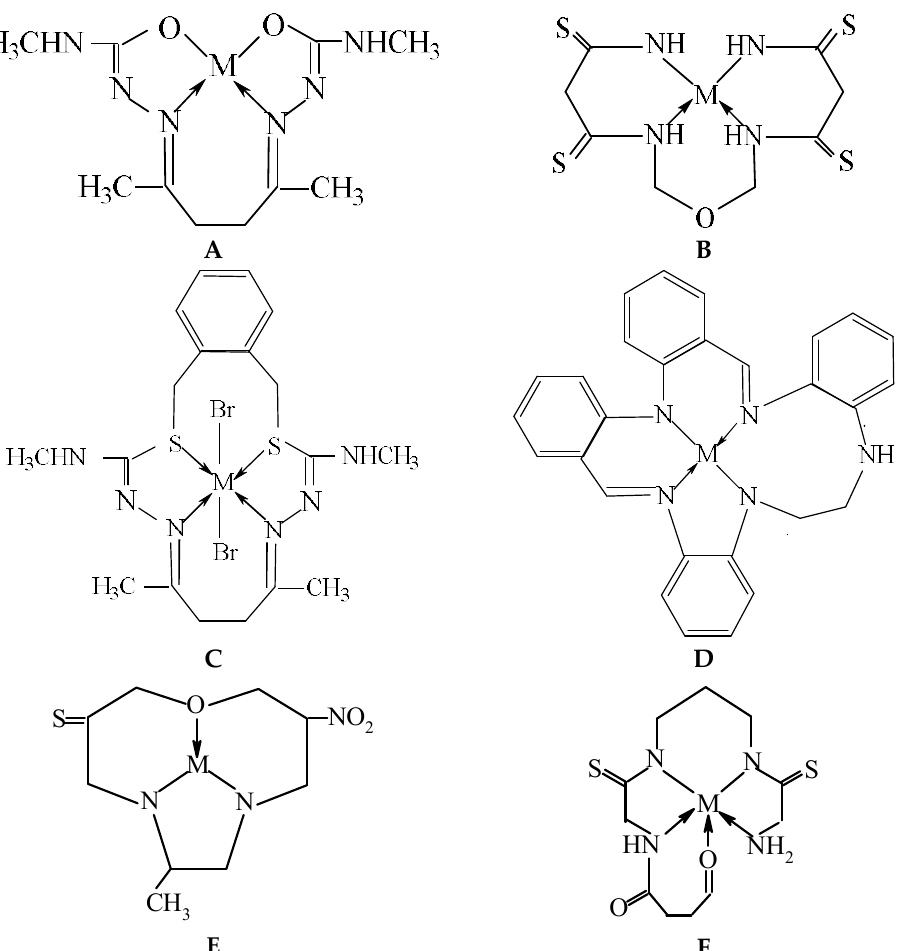
Figure 3. The examples of macrocyclic metal complexes with open contour ( A , B , F ) and closed contour ( C – E ).